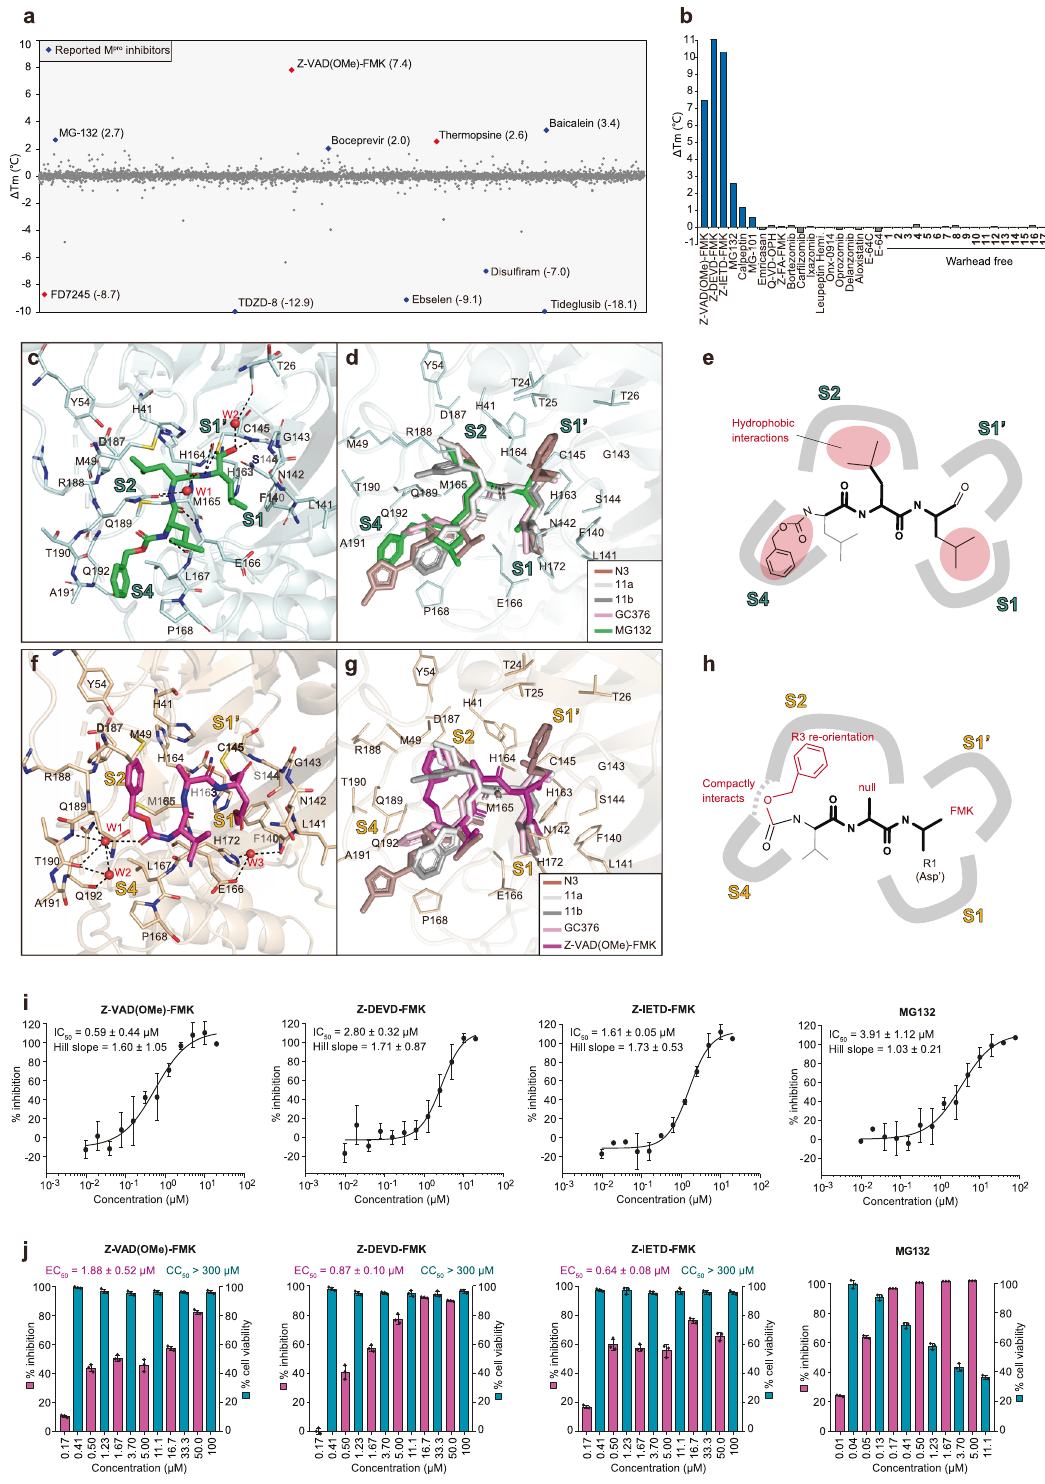
Fig. S4e). Due to R3 re-orientation, the binding mode of Z-VAD (OMe)-FMK to M pro is completely different from that of previously reported M pro inhibitors (Fig. 1g). The four features of M pro -Z-VAD (OMe)-FMK binding (Fig. 1h) — FMK acting as the warhead, absence of R2, re-orientation of fl exible hydrophobic R3, and compact occupation of the S2-S4 joint site — may contribute to the Signal Transduction and Targeted Therapy (2021)